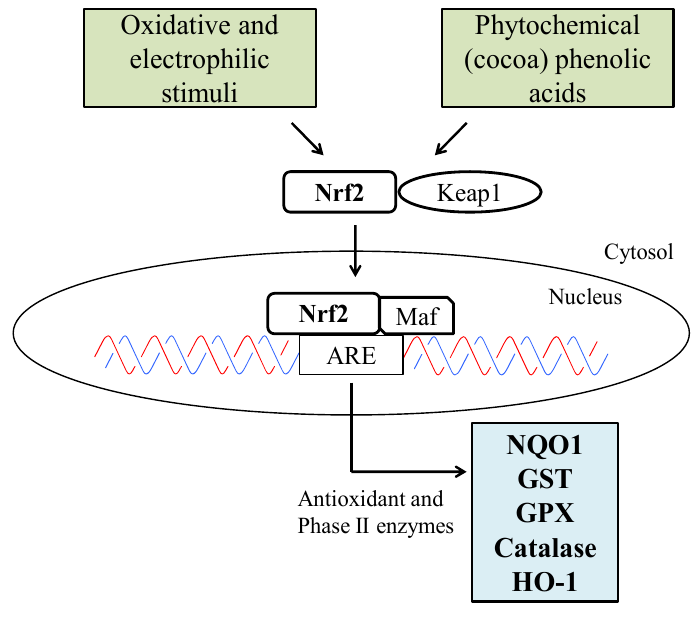
Figure 2. Schematic presentation of the Nrf2 pathway. When oxidants, such as ROS, RNS and dietary phytochemical compounds react with redox reactive cysteines in Keap1, Nrf2 will be released from Keap1, allowing Nrf2 to be translocated into the nucleus. In the nucleus, Nrf2 dimerizes with Maf protein and bind to ARE, which is located in the promoter of the phase II and antioxidative genes, triggering the transcription of ARE-regulated genes. Nuclear factor erythroid 2-related factor 2 (Nrf2); Kelch-like ECH-associated protein 1 (Keap1); musculoaponeurotic fibrosarcoma (Maf); antioxidant response element (ARE); NAD(P)H:quinone oxidoreductase 1 (NQO1);